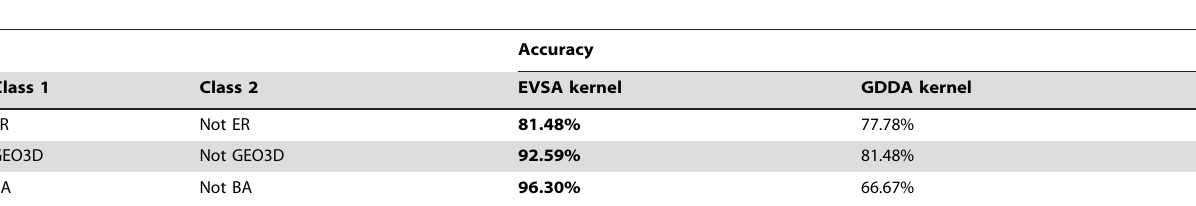
Table 6. The accuracy from 5-fold cross validation of SVM using EVSA and GDDA as